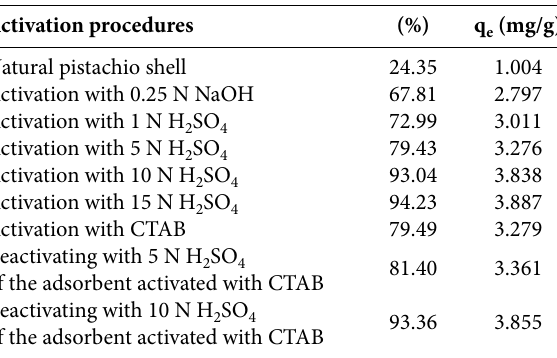
Table 3. AV 17 removal efficiency and adsorption capacity after ac- tivation.